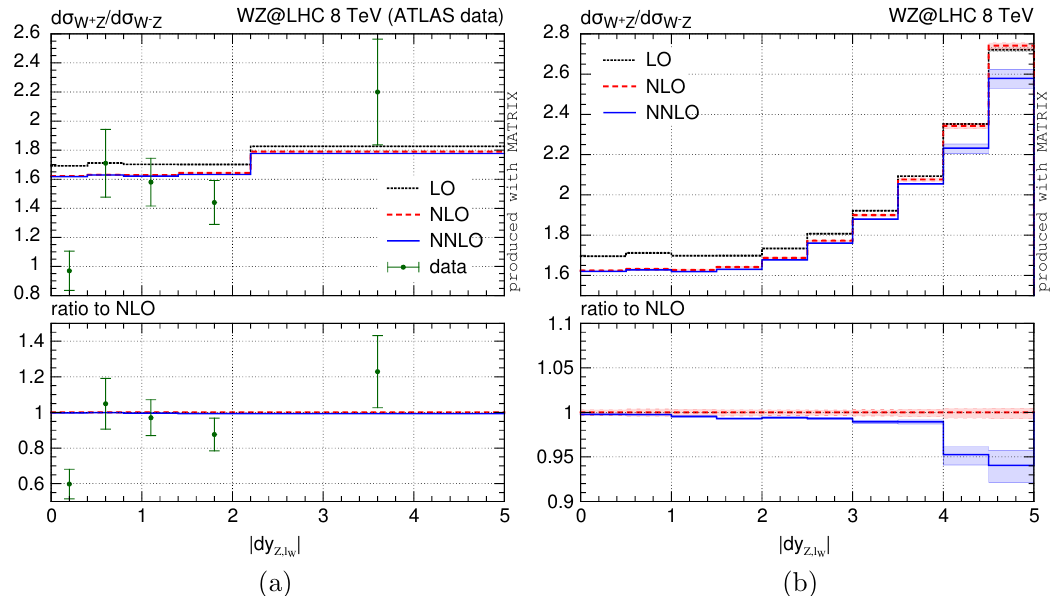
Figure 9 . (a) Same as (cid:12)gure 6 (a), but shows the ratio of cross sections for W + Z and W (cid:0) Z production, and (b) same plot with a di(cid:11)erent binning and without data.